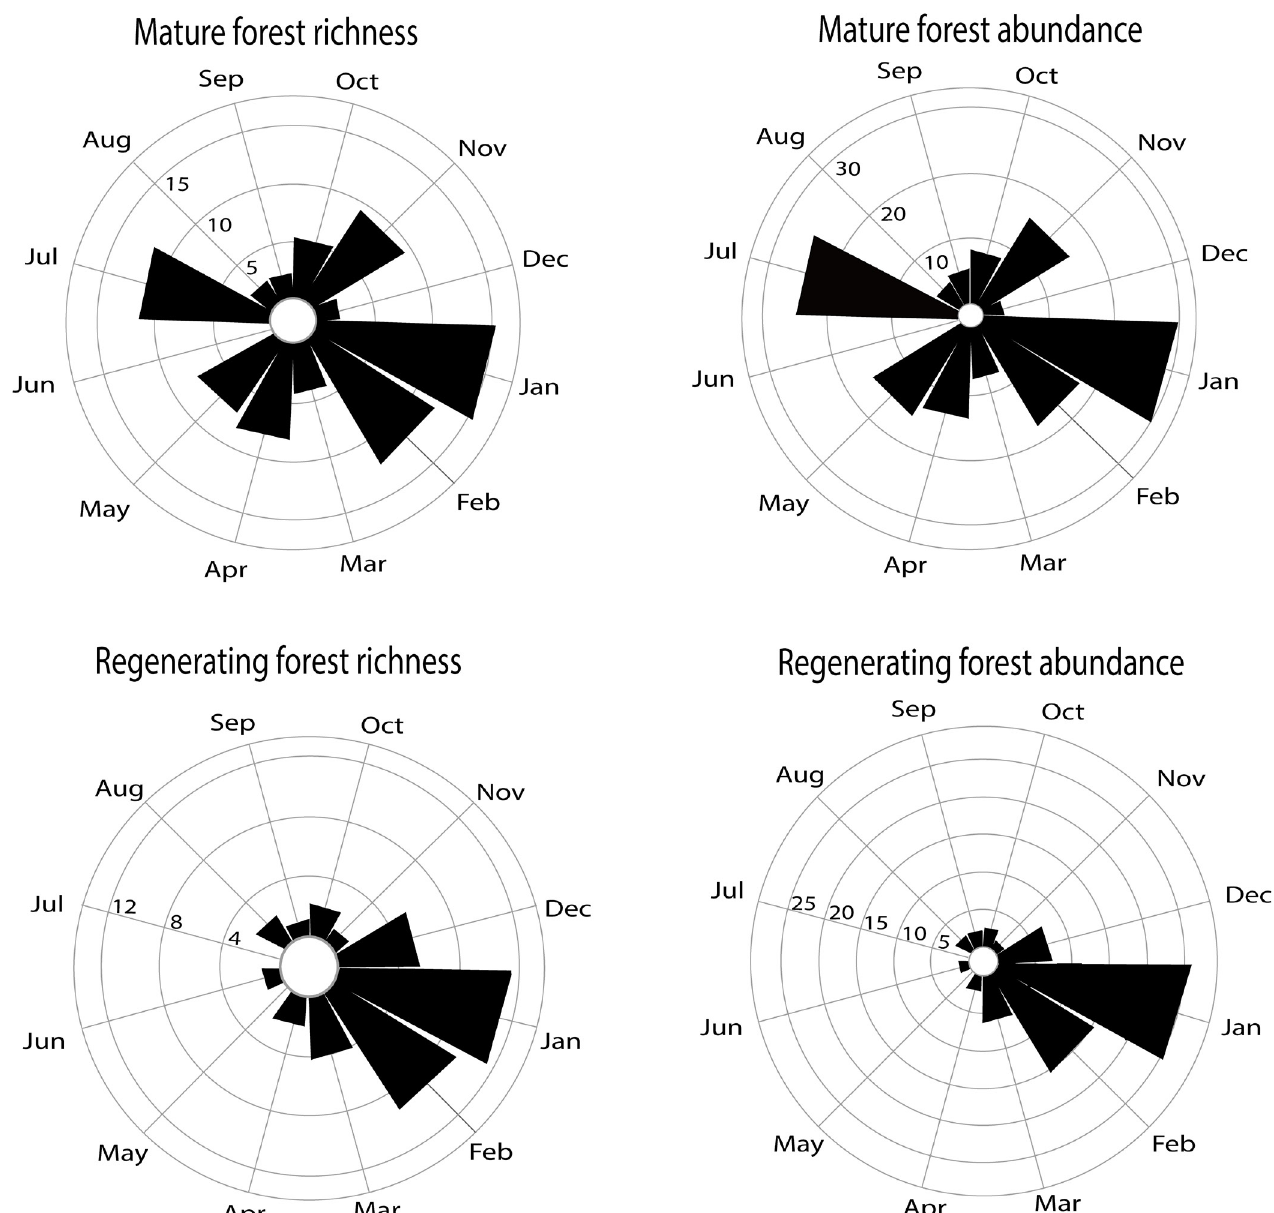
Fig 3 . Circular distribution of the abundance and richness of bees, represented by the total number of bees sampled per month in the two forest fragments (mature and regenerating forest) of the Atlantic Forest, Paraná, southern Brazil. From October 2013 to September